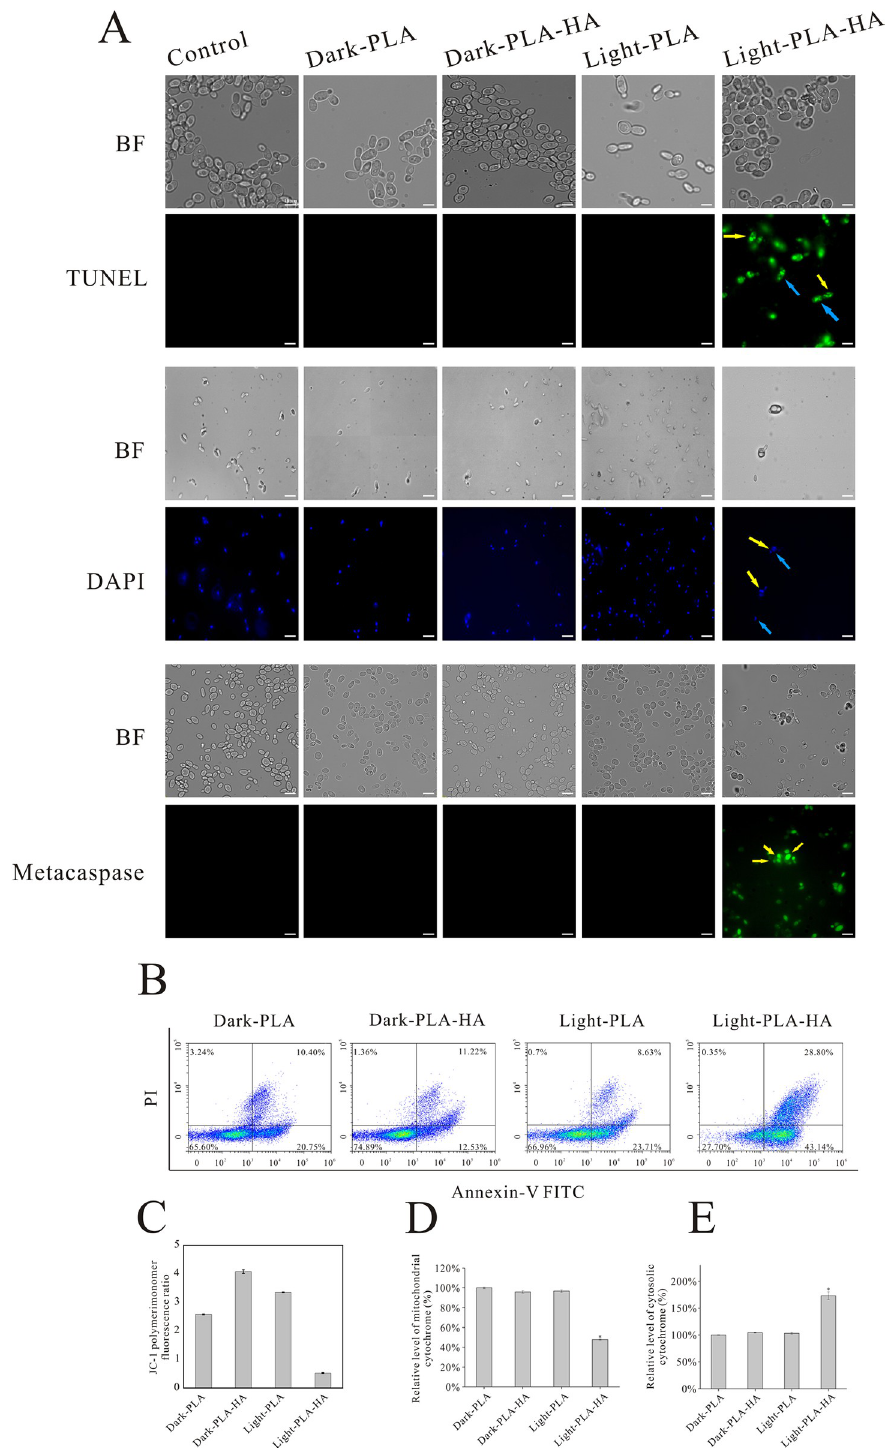
Fig 7. Antifungal Mechanism of PLA-HA mediated aPDT. (A) TUNEL, DAPI and Metacaspase detected by fluorescence microscopy. Scale = 10 μ m. (B)Apoptosis of C . auris cells by staining with Annexin V-FITC and PI. (C) Mitochondrial membrane potential was evaluated using JC-1 staining. (D&E) Cytochrome C release from mitochondria to cytoplasm was assayed after treatment. Data are presented as the mean ± s.d.